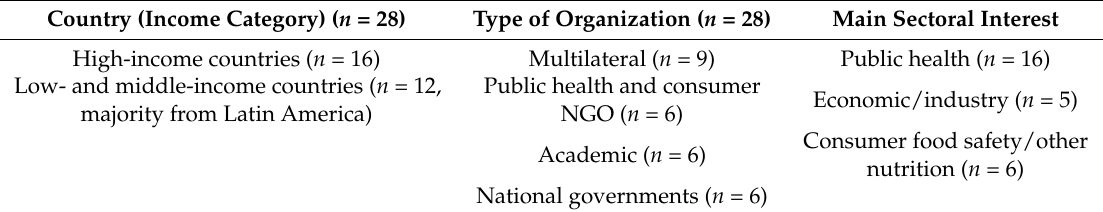
Table 1. Summary of interviewees and